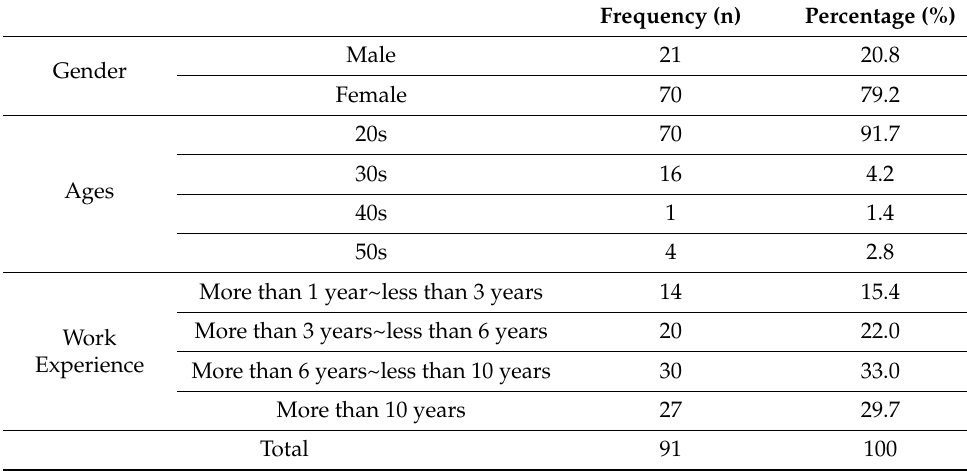
Table 1. Demographic characteristics of the